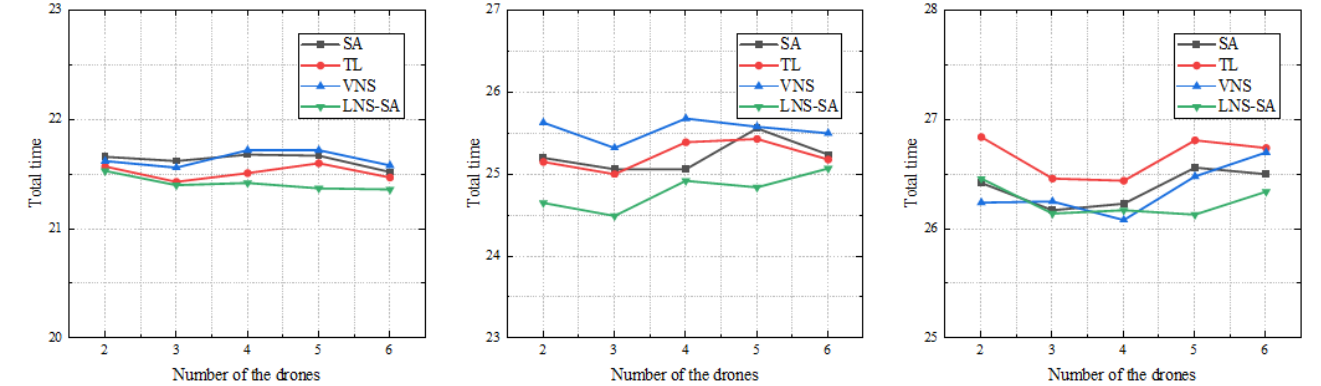
Figure 12. Comparison of results with different drone numbers.